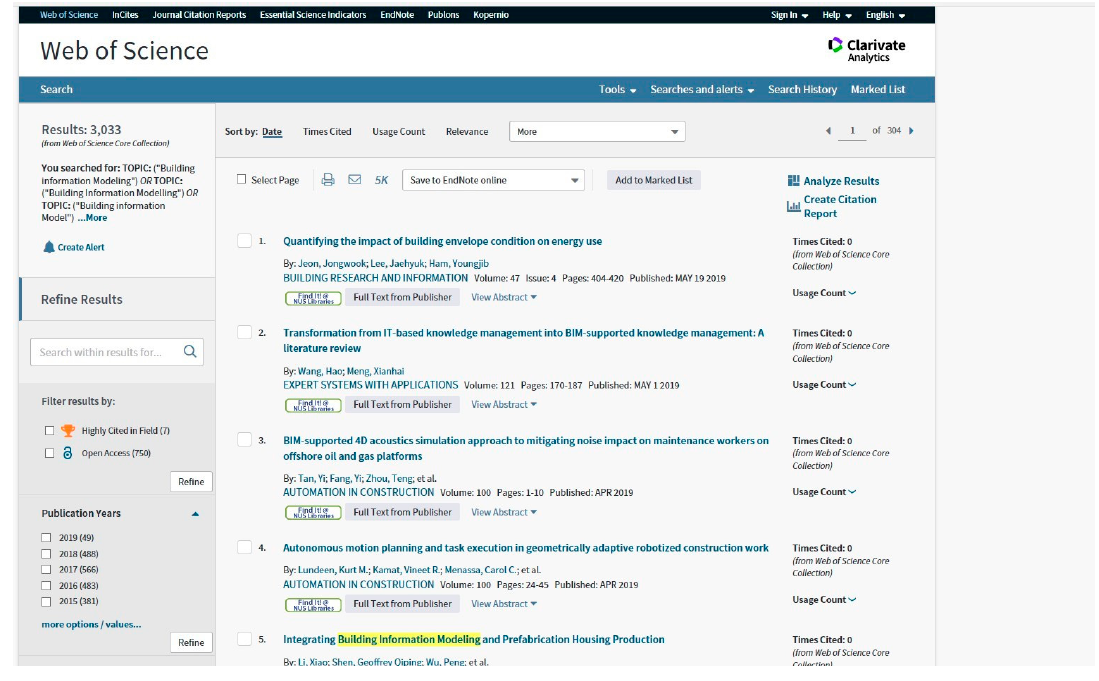
Figure 2. Article retrieved. Table 1. Articles retrieved at di ff erent